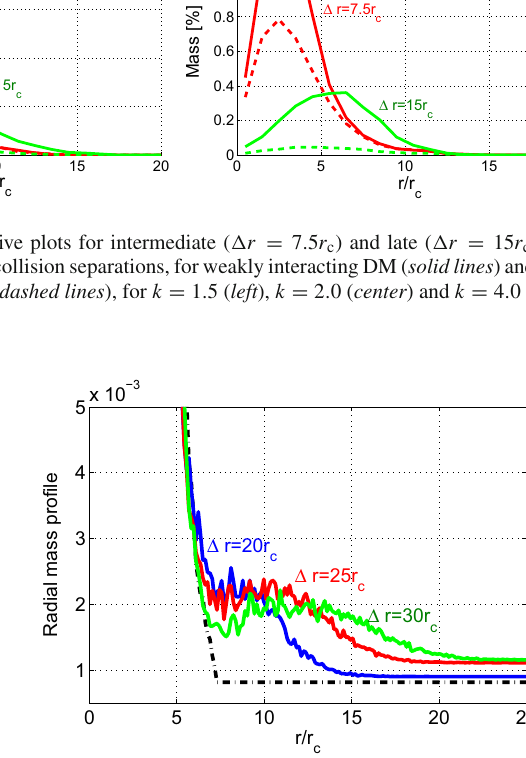
Fig. 12 The scattered DM shell in the tail of the radial mass profile of a very high-speed galaxy cluster collision seen along its collision axis, observed at very late post-collision stages. The thick black dash-dotted line illustrates the behavior of the galaxy clusters’ mass profile at the boundaryofthegalaxyclusters,nearandatthebackgrounddensity,and, thus, the behavior of the radial mass profile expected in the absence of DM scattering rim with the remainder of the mass, that is, having the pro- M /( 2 π rh ) . For a scat- jected surface density of σ shell ≈ 1 2 tered DM shell carrying a fraction a of the total mass of ( log ( 1 + c ) − the collided DM halos, M tot ≈ 2 × 4 πρ 0 r 3 c c /( 1 + c )) , and having a width of h ≈ 2 r c , we thus obtain ≈ a ρ ( log ( 1 + c ) − c /( 1 + c ))/ r . For a more gen- σ 2 shell 0 r c eral, nonuniform shell of scattered DM material, we write = 2 β a ρ ( log ( 1 + c ) − c /( 1 + c ))/ r , where β ≈ 0 . 5 σ 2 shell 0 r c is a numerical factor defining the fraction of the mass con- tained in the circular rim for specific radial profile of the shell. Considering that σ max ≈ 2 r c ρ 0 , we then can arrive at Eq. (11). Equation (11) allows us to estimate the magni- tude of such a scattered DM ring-like feature more generally between 0.1 and 2% of the peak projected mass density. Inter- estingly, Ref. [29] reports observation of such a ring-like DM structure in the long-range reconstructions of the mass pro- file of the galaxy cluster CL 0024+17, having compatible magnitude between 1 and